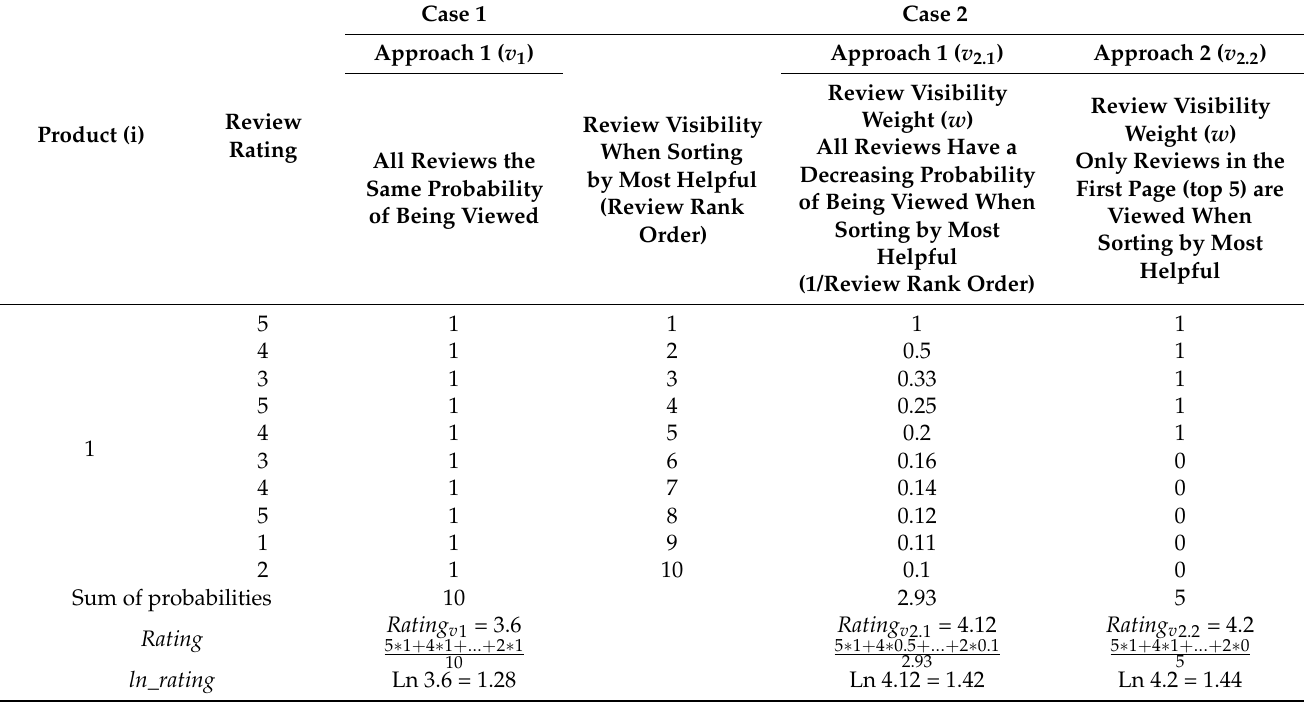
Table 2. Example of aggregation process of review variables for a specific product i at a specific time t